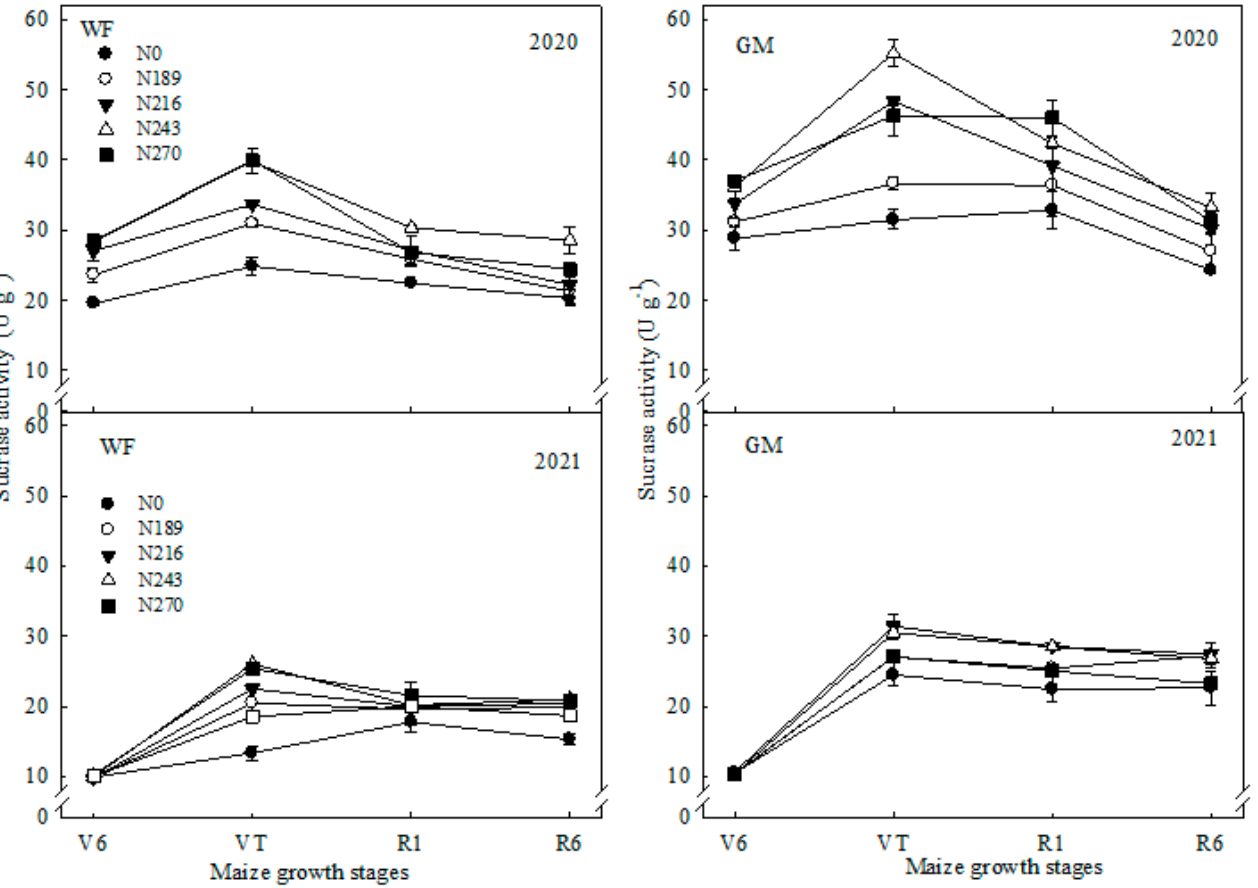
Figure 3. The soil sucrase activity response to N application under WF and GM treatments in the North China Plain. V6, spring maize jointing stage; VT, spring maize tasseling stage; R1, spring maize filling stage; R6, spring maize maturity stage.